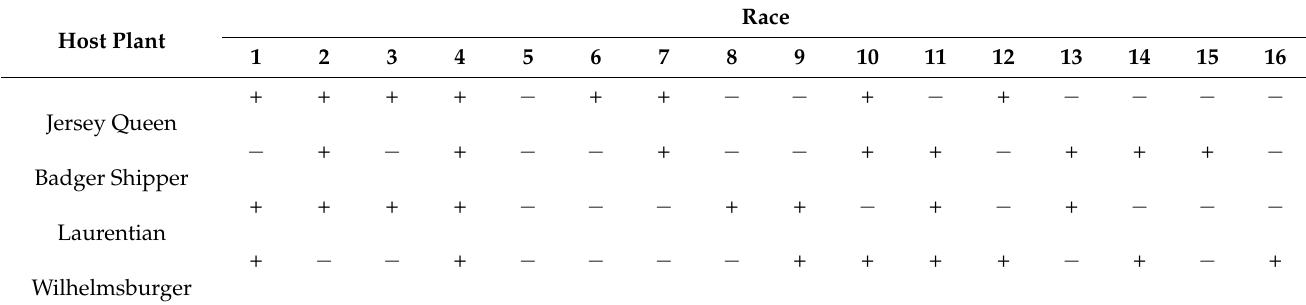
Table 1. The Williams classification system